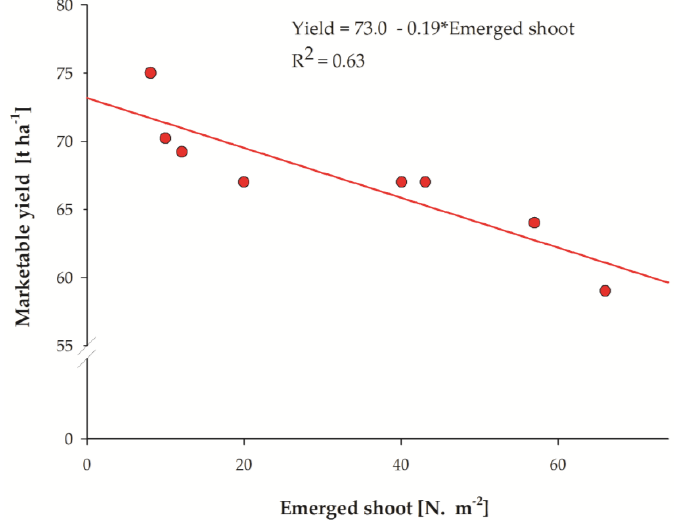
Figure 2. Relationship between tomato marketable yield and number of emerged branched shoots of P. ramosa detected at the end of the tomato cycle (harvesting time).